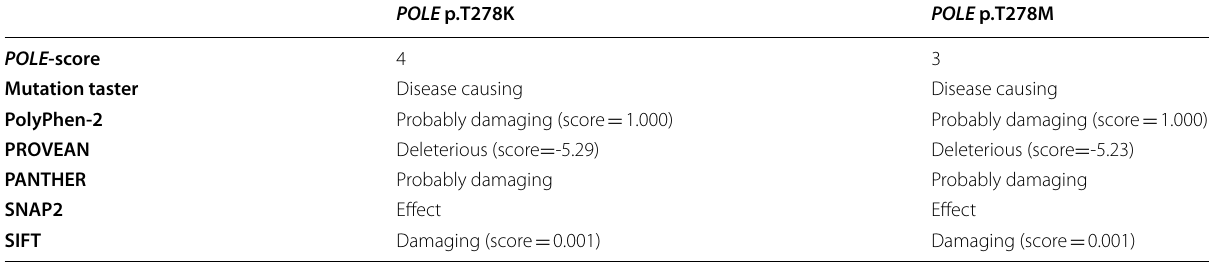
Table 3 In silico predicting results for the two